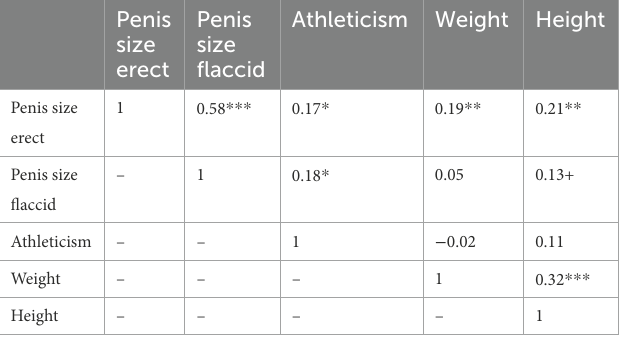
TABLE 1 Zero-order correlations between erect and flaccid penis size, athleticism, weight, and height. Penis